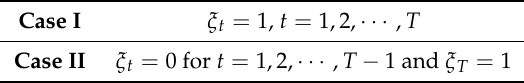
Table 4. Parameter setting in two cases.